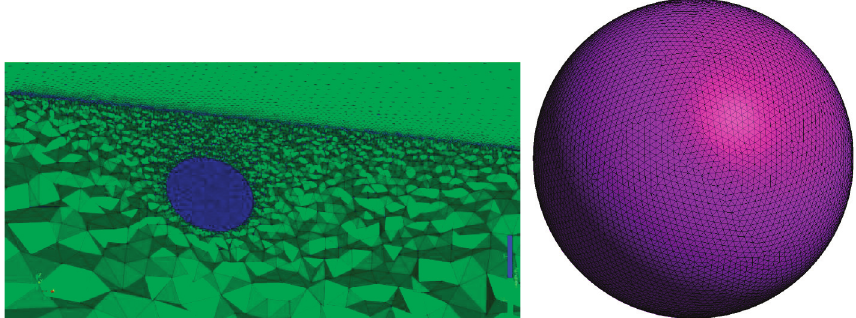
Figure 2: Partial magnification effect of the mesh division.